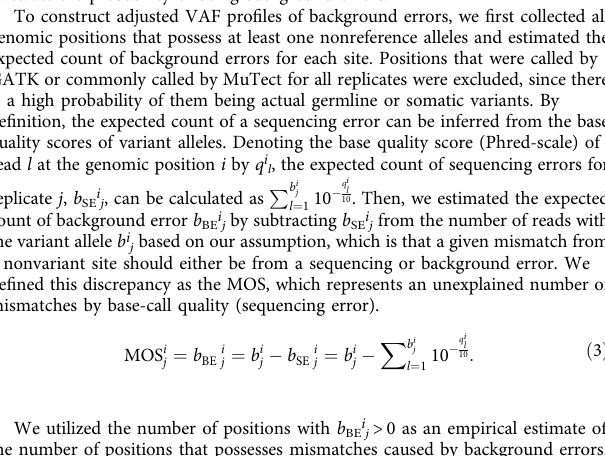
Fig. 4 Comparative performances of RePlow and the primitive approaches. a Performance assessment with the library replicates of test-base data. FPR, precision, sensitivity, and F -score were measured for sample B (1% VAF). All three combinations of duplicates were tested, and their average performances were reported with 95% con fi dence intervals (typically smaller than marks). b Performance assessment with the combination of replicates in multiplatforms. All pairs of library replicates between different platforms were tested with test-base data of sample B. Only the data sets with the highest depth of each platform were used for the combination (1000× for ILH and 10,000× for ILA and ITA). Error bars, 95% con fi dence intervals. c Independent assessment with a reference material sequenced by two widely-used cancer panels. Detection of 35 true cancer hotspot SNVs (1 – 1.3% VAF) were tested for all combinations of library triplicates (X 1 X 2 , X 2 X 3 , X 1 X 3 , and X 1 X 2 X 3 are denoted as 1, 2, 3, and T, respectively). Green shading means a correct detection, and other colors represent the reason for the rejection or no detection (with X marks). FPRs of RePlow are highlighted in orange to emphasize their reductions therein, compared to other primitive approaches. d Experimental validation of rescued low-level mutations from the samples negative for pathogenic mutations in previous analysis. Observed allele counts are described in each replicate (left). Droplet digital PCR results for no DNA template (No template), DNA from healthy controls (negative), and disease samples are shown together for each site (right). Green and blue dots represent wild type- and mutant-speci fi c signals, respectively. Source data for a , b are provided as a Source Data